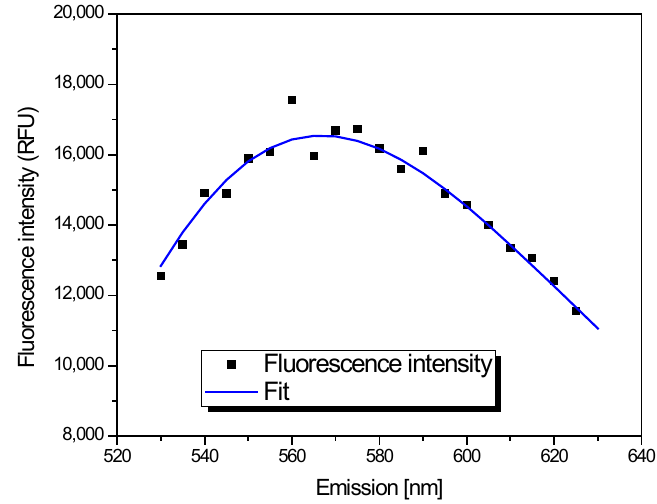
Figure 10. Spectral fitting of local intensities and emission spectra maximum wavelengths.